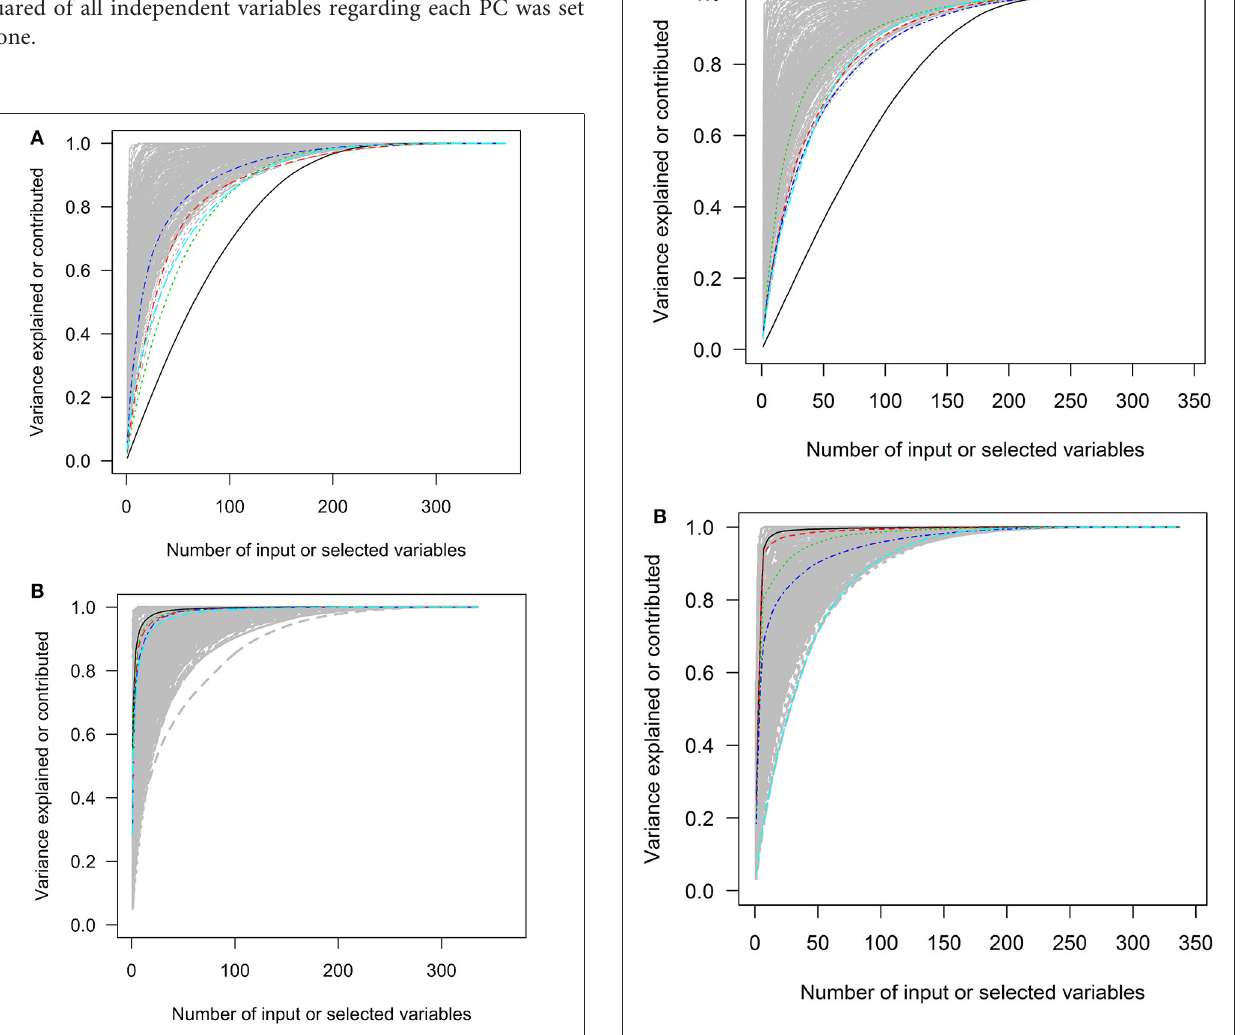
Frontiers in Digital Humanities |